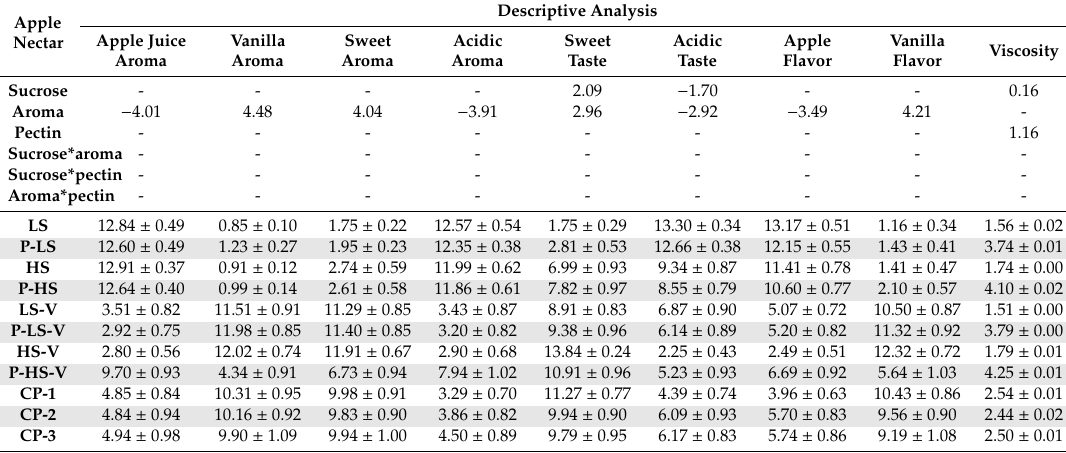
Table 4. Scaled and centered coe ffi cients for significant main e ff ects and 2-way interactions as well as means ± std. error of the mean for the samples in the apple nectar matrix. Viscosity means are in cP. Samples are labelled according to Table